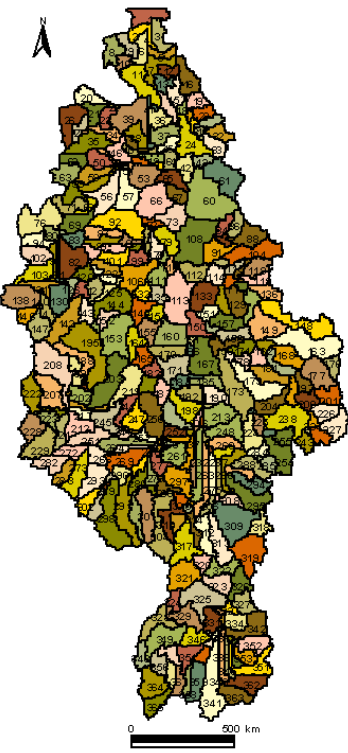
Fig. 3. Delineated regions of the River Nile basin showing different homogeneous regions and their spatial